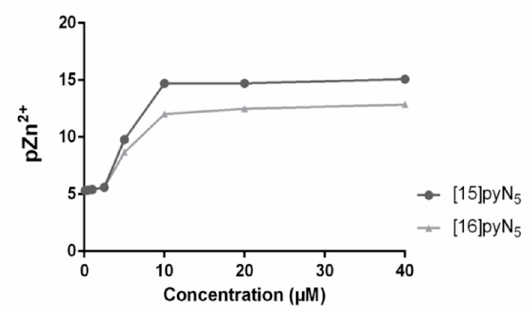
Figure 6. Values of pZn 2 + (-log[Zn 2 + ]), calculated for an aqueous solution of pH 7.4 containing Zn 2+ (5 µM) and [16]pyN 5 and [15]pyN 5 (0.1–40 µM).